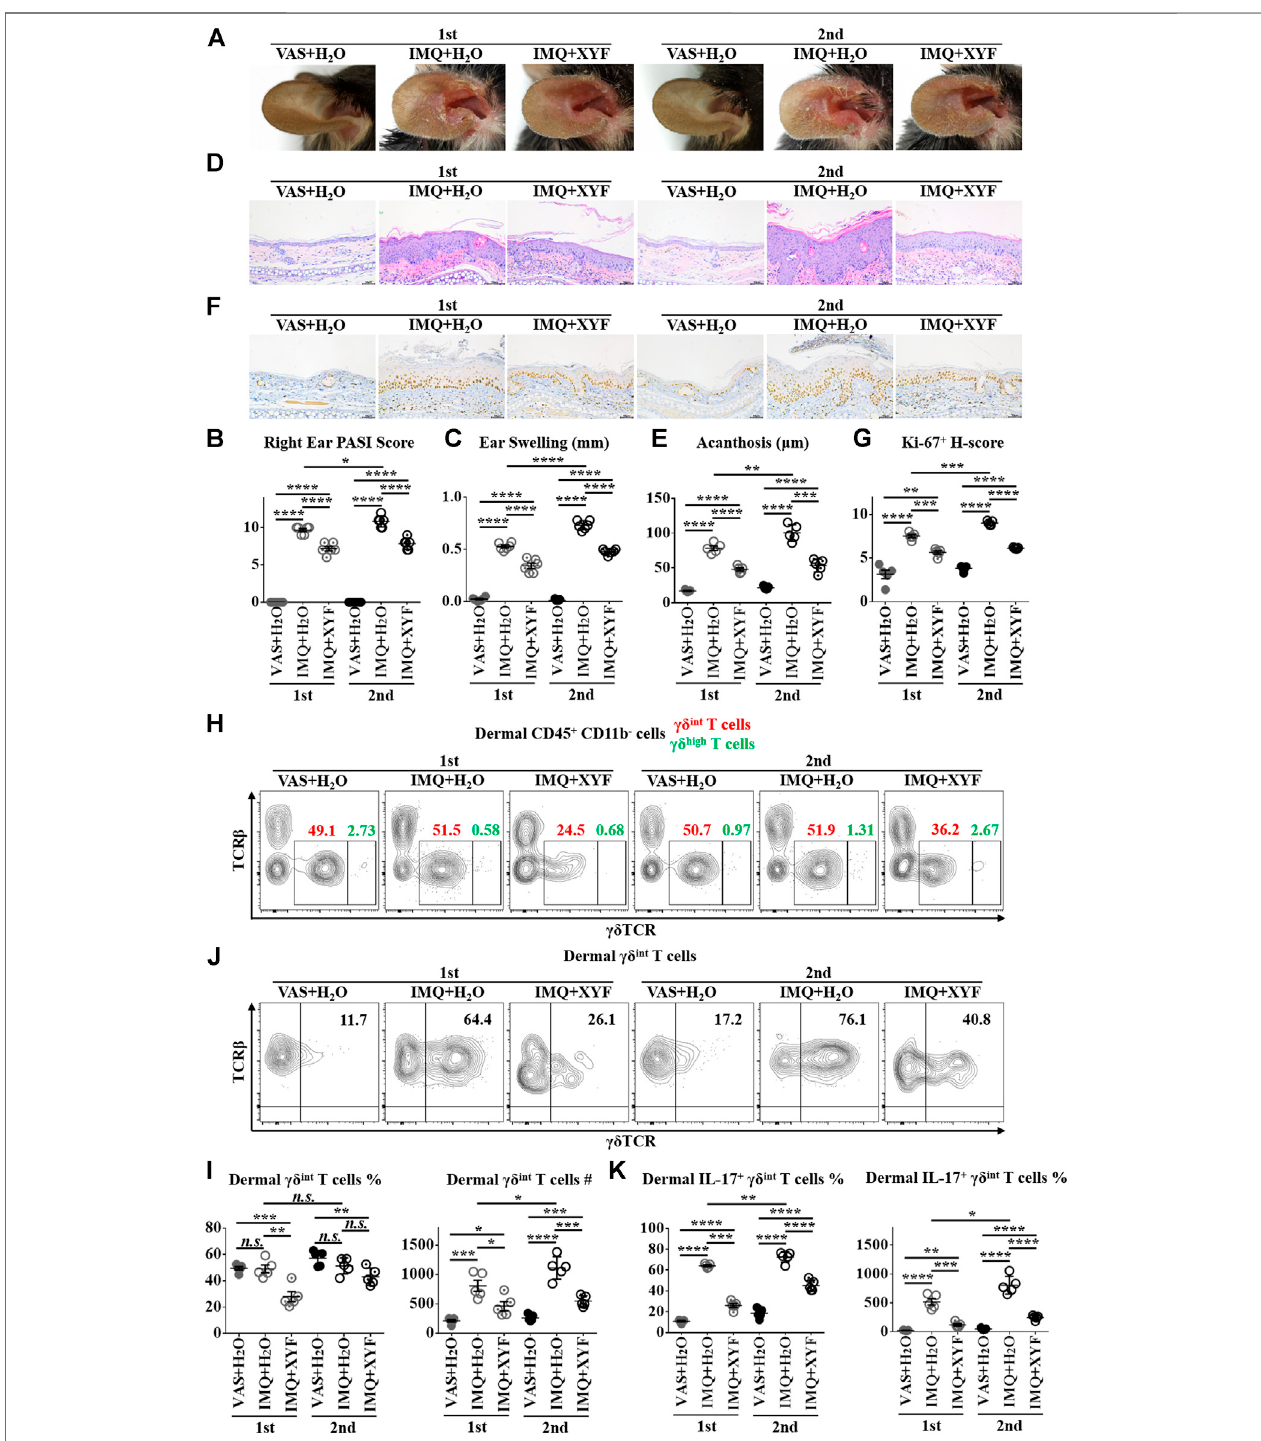
FIGURE6 | Xiao-Yin-Fang alleviatedthe relapse ofpsoriasis-like dermatitis and prohibited dermal γ δ int Tcell reactivation. Mice were treated asin Supplementary Figure S7 . (A) Representative pictures of mouse right ear lesions (1st: the initial occurrence of psoriasis-like dermatitis; 2nd: the recurrence of psoriasis-like dermatitis). (B, C) Evaluation of PASI score (B) and skin swelling (C) of mouse right ears ( n (cid:2) 36, two independent experiments). (D) H&E staining and calculated epidermal acanthosis (E) (x200; bar (cid:2) 50 μ m; n (cid:2) 30, two independent experiments). (F) Ki-67 staining and assessment of its H-score of epidermal fi elds (G) (x200; bar (cid:2) 50 μ m; n (cid:2) 30, two independent experiments). (H-K) Freshly isolated dermal cells were in vitro cultured in the presence of PMA, ionomycin and Brefeldin A for 4 h. Cultureddermalcellswerestainedwithanti-CD45,TCR β , γ δ TCR,CD11b,andIL-17antibodies( n (cid:2) 30,twoindependentexperiments). (H) Representativescatterplots of dermal γ δ int T cells and γ δ high T cells. (I) The ratios and numbers ofdermal γ δ int Tcells. (J) Representativescatter plotsof dermal IL-17 + γ δ int Tcells. (K) The ratios and numbers of dermal IL-17 + γ δ int T cells. The data were presented as mean ±